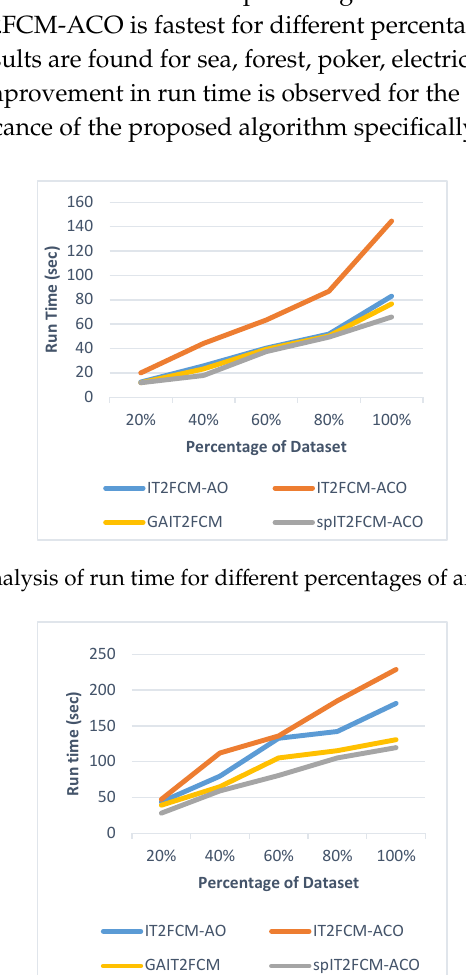
Table 8. Evaluation of Speed Up.